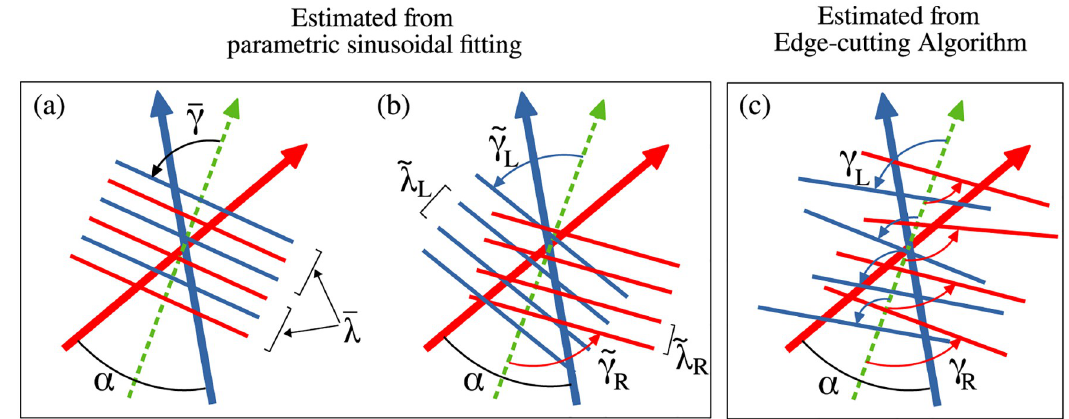
Fig 6. Summary of different methods to estimate orientation γ and physical separation λ of the stripes. The arrows in blue and red represents the direction of motion of the two groups. The schematic diagrams are shown for an arbitrary crossing angle. The dashed green arrow indicates the bisector of the crossing angle between the two group direction vectors. The lines in blue and red show the stripes from the two groups. γ is the angle between the direction of stripes and the bisector of crossing angle, always measured counterclockwise. (a) Estimation of orientation � g of the stripes and physical separation � l between two stripes from the same group using the parametric sinusoidal fitting. In doing this calculation it was assumed that stripes from the two groups are parallel to each other and are equispaced, as shown in the figure. (b) Orientation of the stripes from the two groups when we assume that stripes from the same group are parallel to each other and are equispaced. ~ g group direction vectors are left and right to the direction of bisector respectively. Using the same convention, ~ g spatial separation between the stripes in those cases. This calculation was also done by fitting the two dimensional sine curve. (c) Estimation of orientation of the individual stripes that were found using the edge-cutting algorithm, for the two groups. γ L or γ R denote the orientation of individual stripes whose group direction vector is left or right to the direction of bisector respectively.